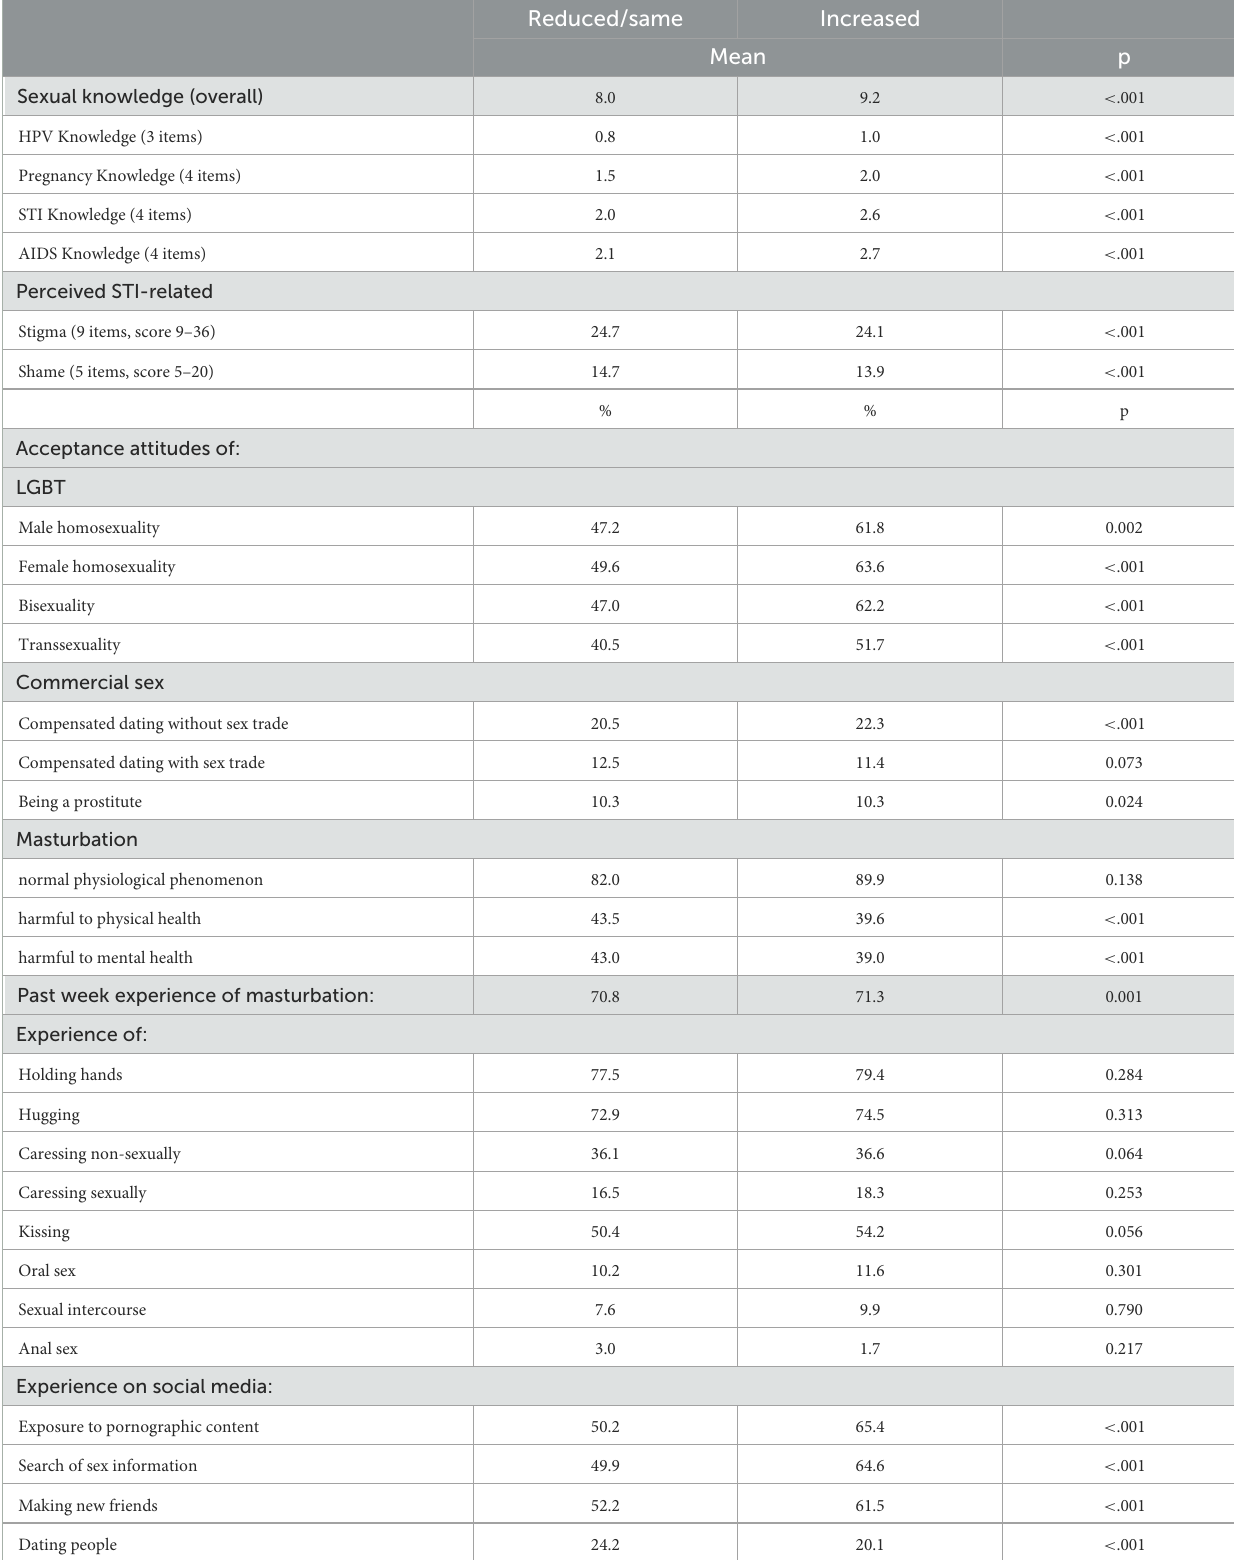
TABLE 3 Univariate analysis of time spent on electronic device on sexuality/sexual health during COVID-19 after controlling for gender, age, satisfaction with school life and academic performance. The amount of time spent on electronic devices during COVID-19 Reduced/same Increased Mean p Sexual knowledge (overall) 8.0